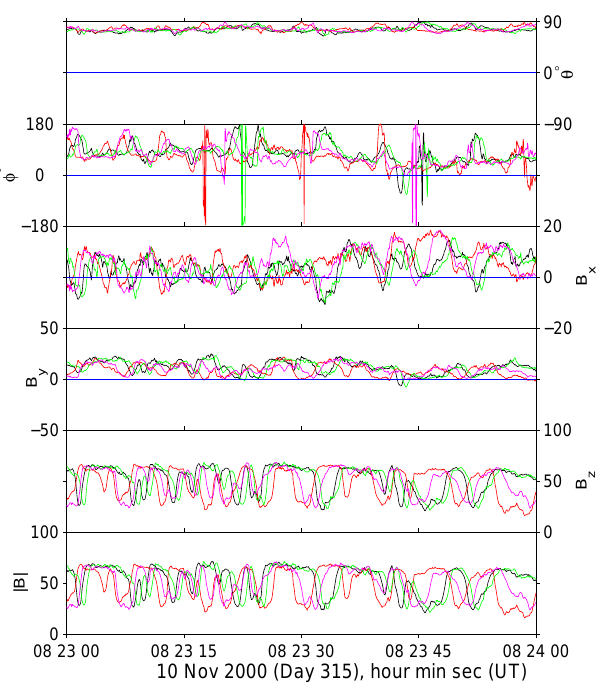
Fig. 3. One minute of magnetic field data showing mirror-like ac- tivity. Panels have the same format as in Fig. 1. Data from all four spacecraft are shown using the same colour-coding as in Fig. 2.